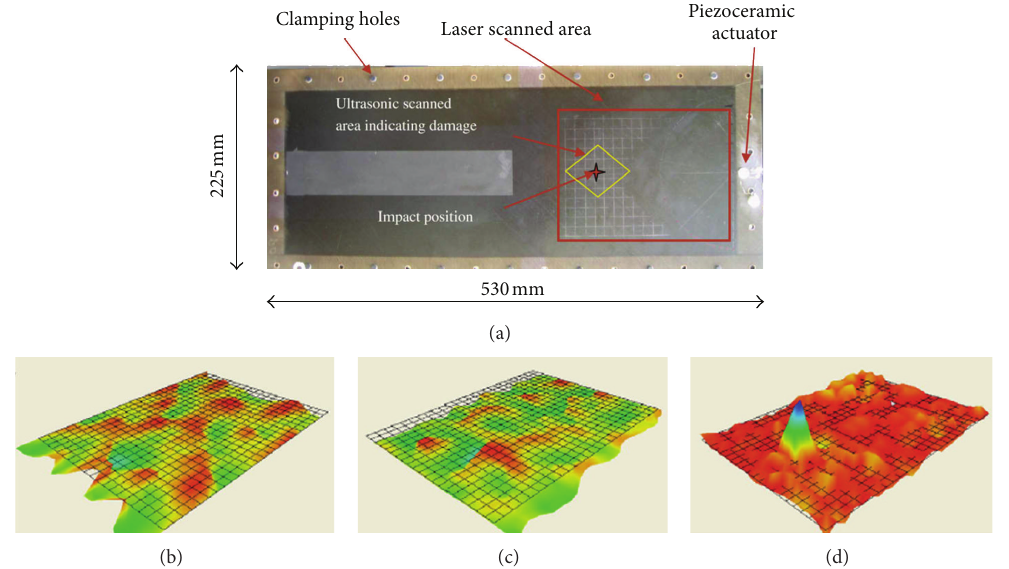
Figure 29: Combined use of piezoelectric actuator and laser vibrometer for SHM of aerospace composite structures. Composite plate and experimental setup used in active impact damage detection investigations (a) and Lamb wave amplitude in the in-plane x -direction (b), in the in-plane y -direction (c), and in the out-of-plane z -direction (d)